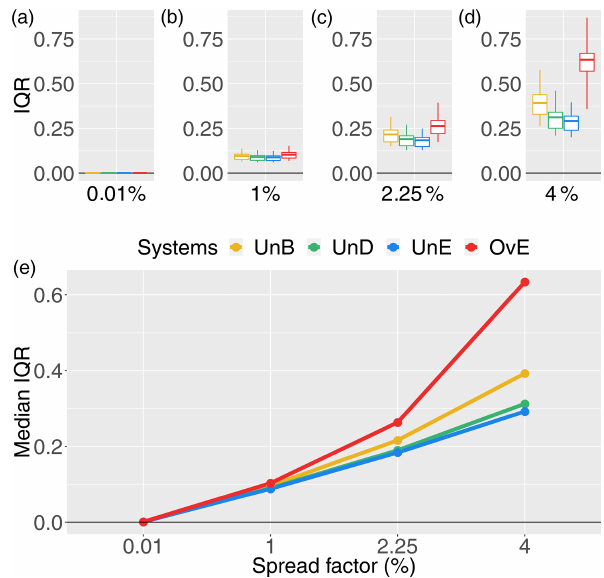
Figure 3. IQR score for 1d ahead synthetically generated forecasts of different quality: unbiased system (UnB, yellow), underdispersed system (UnD, green), underestimating system (UnE, blue) and over- estimating system (OvE, red). Systems are based on ensembles gen- erated with four different spread factors (0.01%, 1%, 2.25% and 4%). (a–d) Boxplots represent the maximum value, percentiles 75, 50 and 25, and minimum value over the 10 studied catchments. (e) Median score